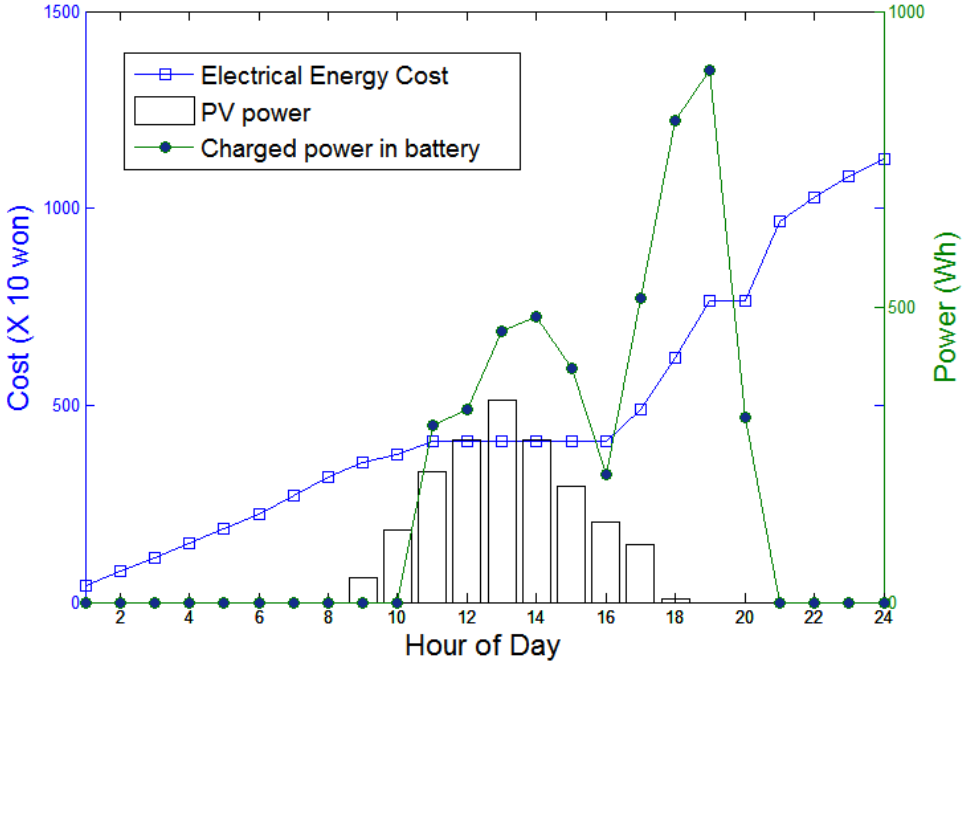
Figure 12. Use of PV power, SOC of the battery and electricity price under Scenario